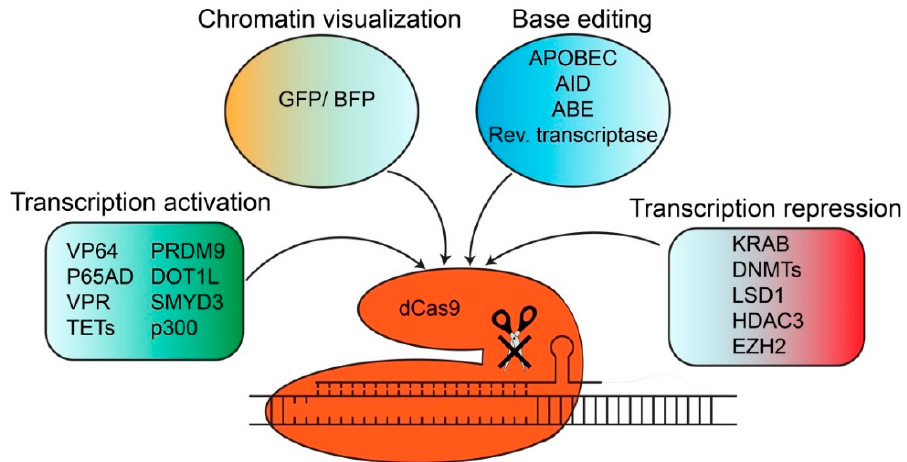
Figure 2. Endonuclease-deficient Cas9 proteins (dCas9) derivatives and their purpose. Overview of the different dCas9 derivatives. Their purpose includes transcriptional activation (via transcriptional activators or epigenetic modifiers), chromatin visualization, base editing and transcriptional repression (via repressor domains or epigenetic modifiers). Rev. transcriptase: reverse transcriptase.